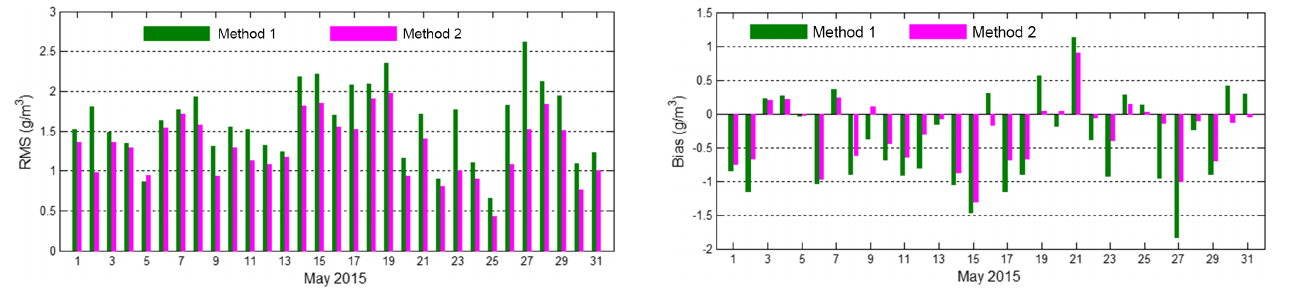
Figure 9. RMS comparison for two methods from 1 to 31 May 2015.